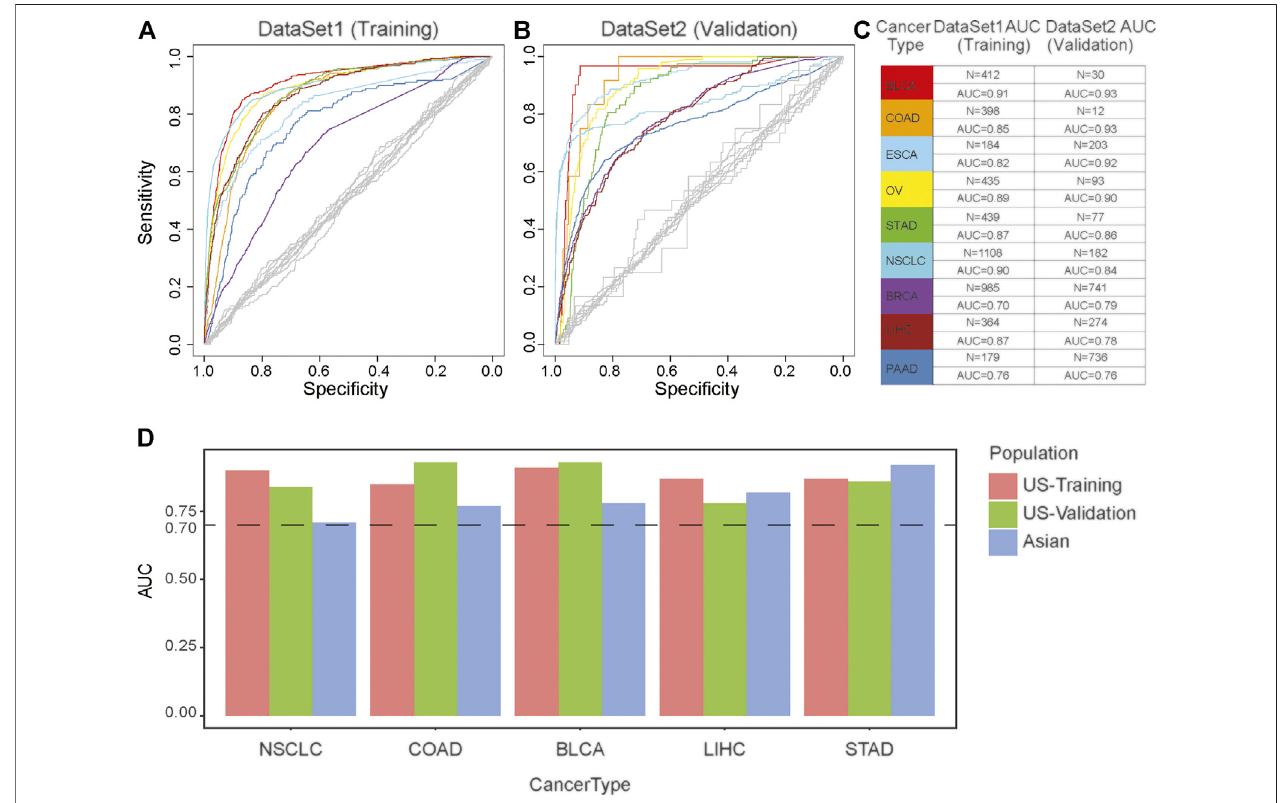
FIGURE 2 | The effectiveness of the cancer diagnosis model based on the MS of the primary tumor. (A,B) AUC-curve of cancer diagnosis models in both training (A) andvalidation (B) cohort.Randomclassi fi ers,indicatingtheclassi fi cationaccuraciesobtainedbychance,areshowningray. (C) ThevalueofAUCandthenumberof patients in both training (left) and validation (right) cohort. (D) The model performance across different populations. The vertical axis is the AUC of model. The horizontal axisrepresentstumortype. RedrepresentsEuropean andAmericanpopulationinthetrainingdataset;GreenrepresentsEuropeanandAmericanpopulationinthe validation dataset; Blue represents Asian populations.